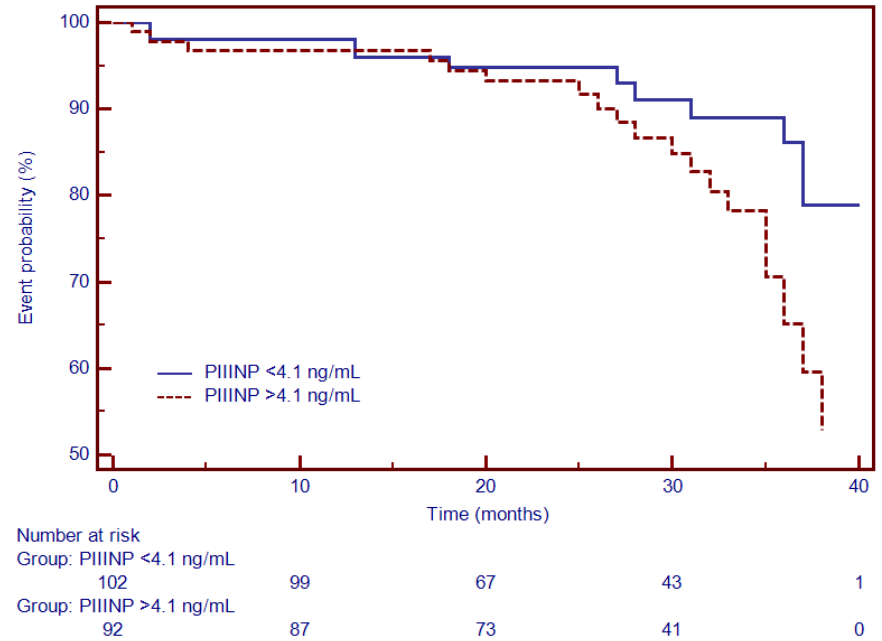
Figure 6. Kaplan–Meier analysis for the ability of PIIINP to predict cardiovascular outcome. Abbrevi- Figure 6. Kaplan – Meier analysis for the ability of PIIINP to predict cardiovascular outcome. Ab- ations: PIIINP, N-terminal pro-peptide of procollagen type III. breviations: PIIINP, N-terminal pro-peptide of procollagen type III.